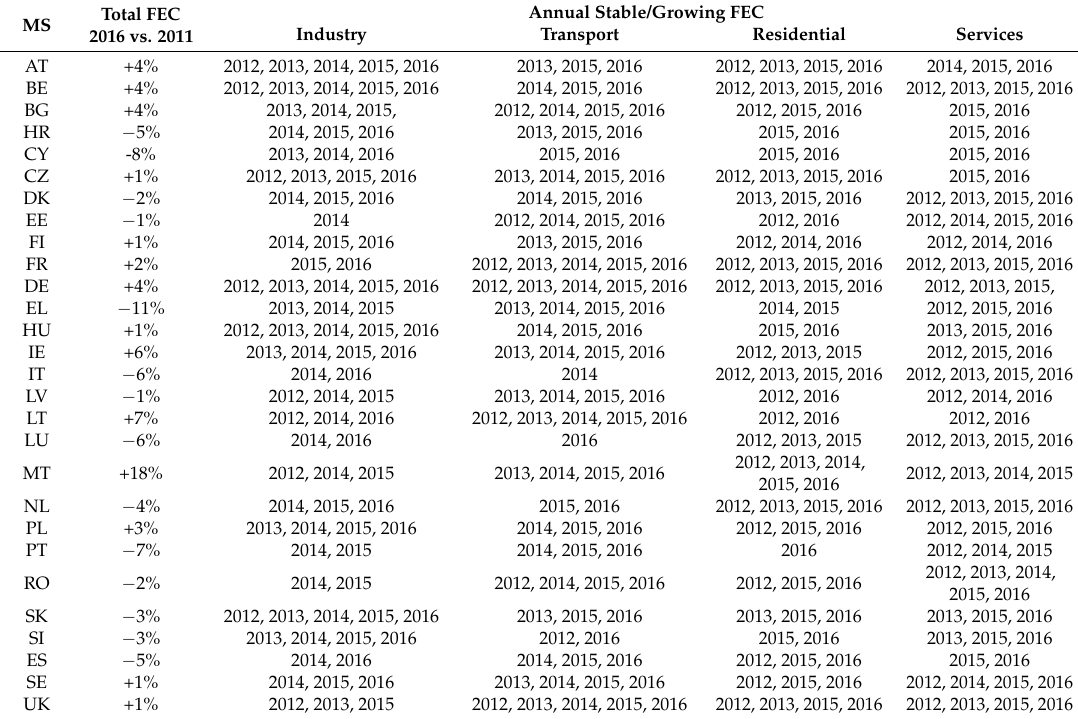
Table 2. Change of Final Energy Consumptions (FEC) over the period 2011-2016 and indication of years in which Final Consumptions (of each sector) has not decreased compared to the previous year. Annual Stable/Growing FEC Total FEC MS Industry Transport Residential Services 2016 vs. 2011 AT